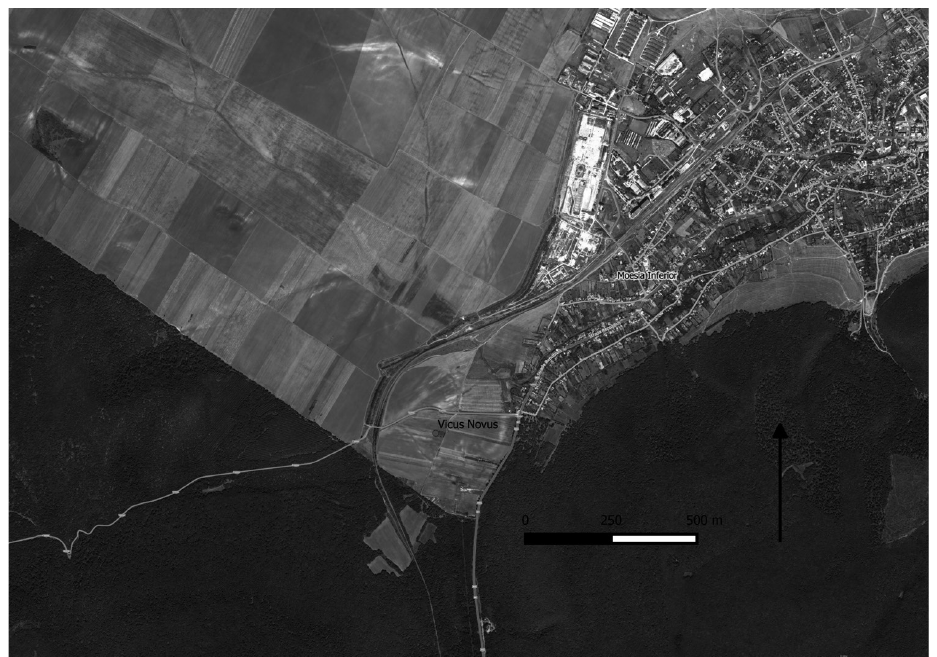
Figure 11: The location of “vicus